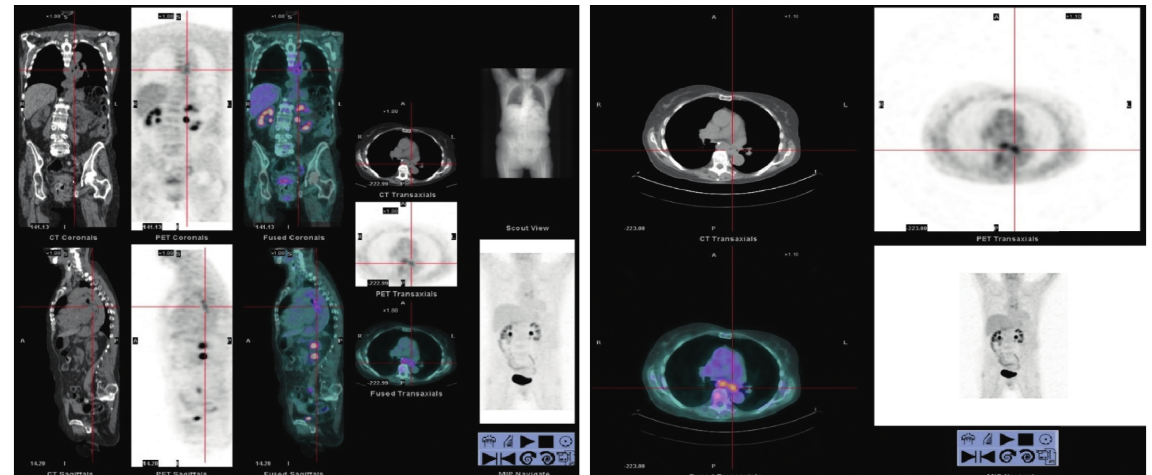
Figure 2: PET-CT showing an already-known metabolically active esophageal lesion, with possible adjacent ganglion